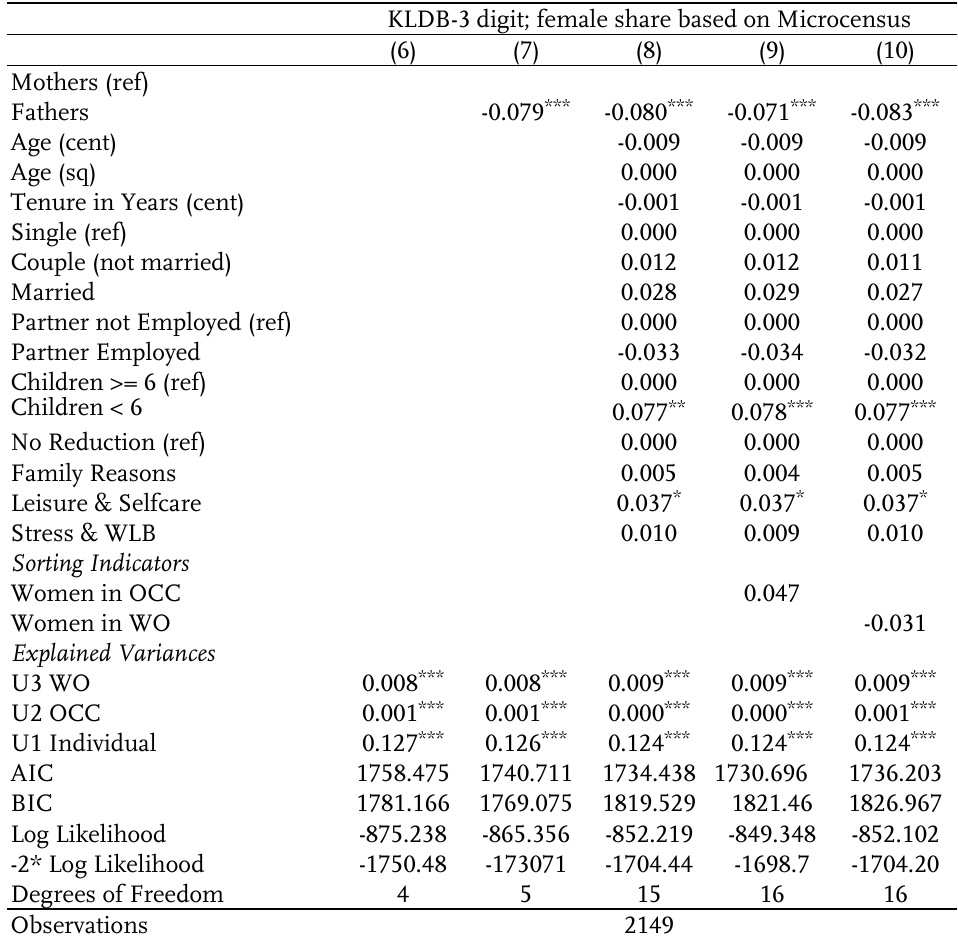
Table A.1 : Sensitivity analyses: Gender differences full-time men & women with different operationalizations of occupations